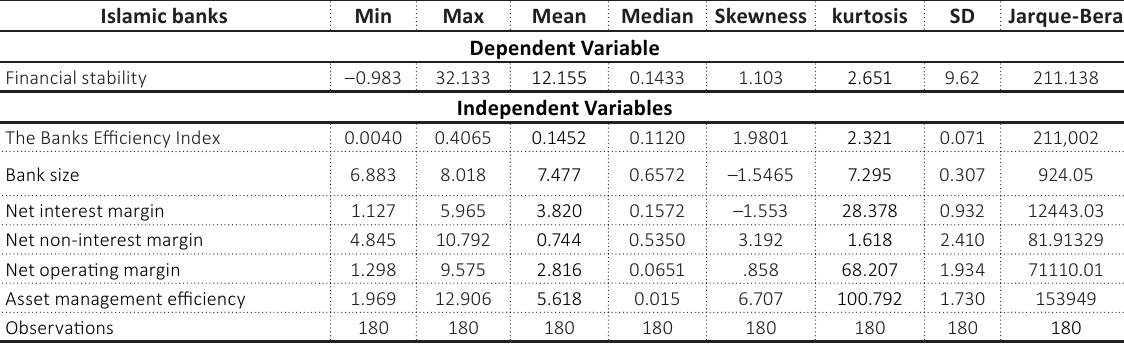
Table 12. Descriptive statistics for Model D